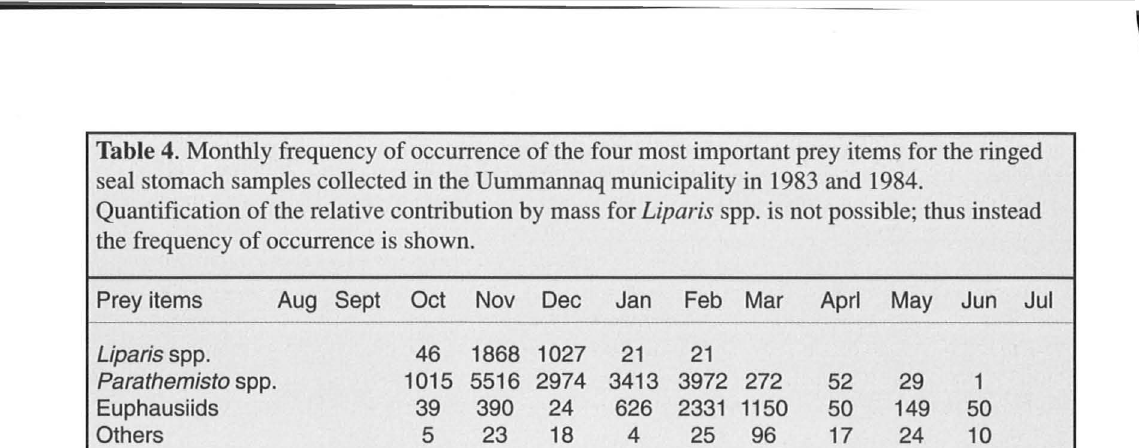
Table 4. Monthly frequency of occurrence of the four most important prey items for the ringed seal stomach samples collected in the Uummannaq municipality in 1983 and 1984. Quantification of the relative contribution by mass for Liparis spp. is not possible; thus instead the frequency of occurrence is shown.